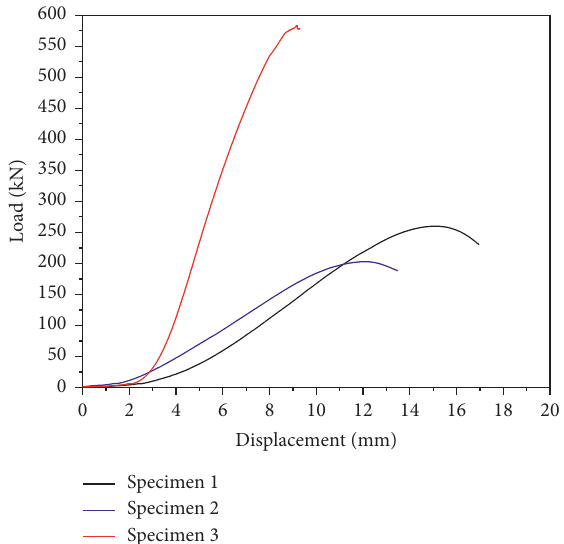
Figure 7: The slant shear test specimen load-displacement curves.